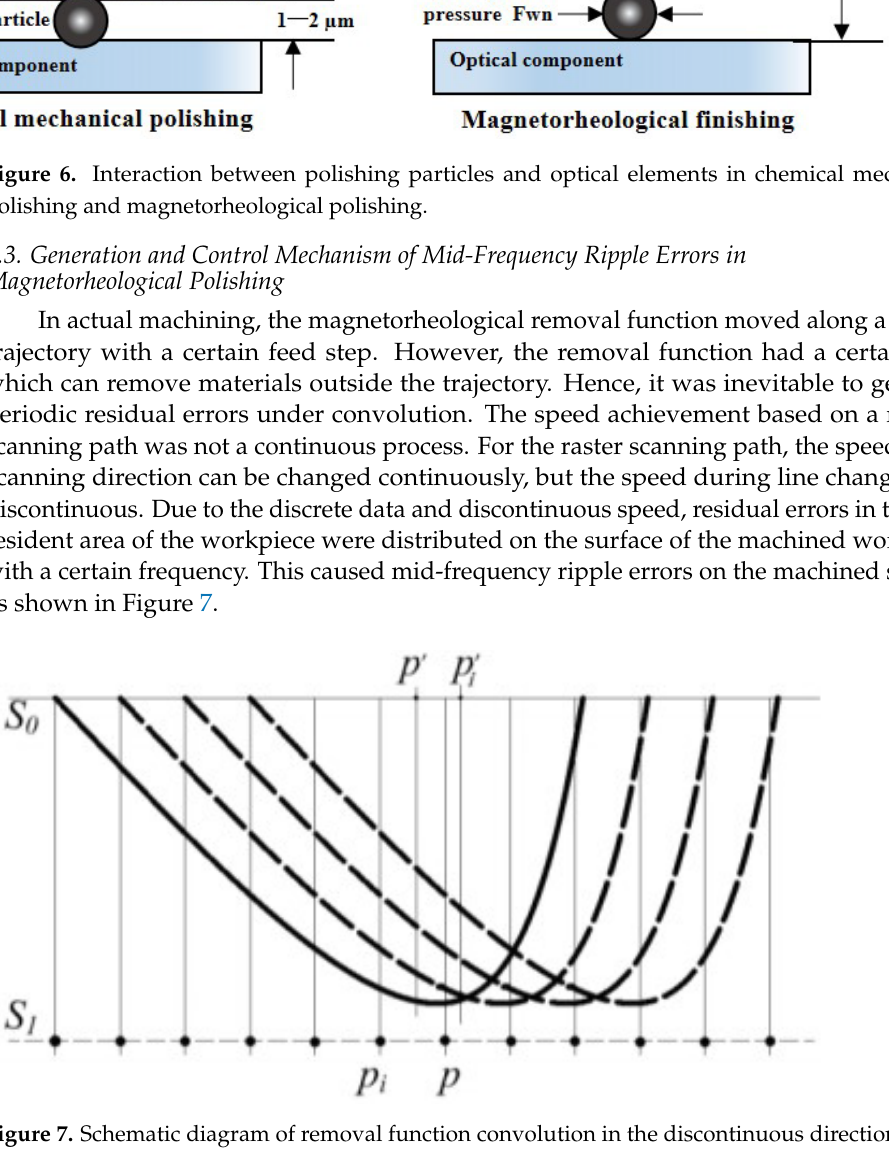
Figure 7. Schematic diagram of removal function convolution in the discontinuous direction.